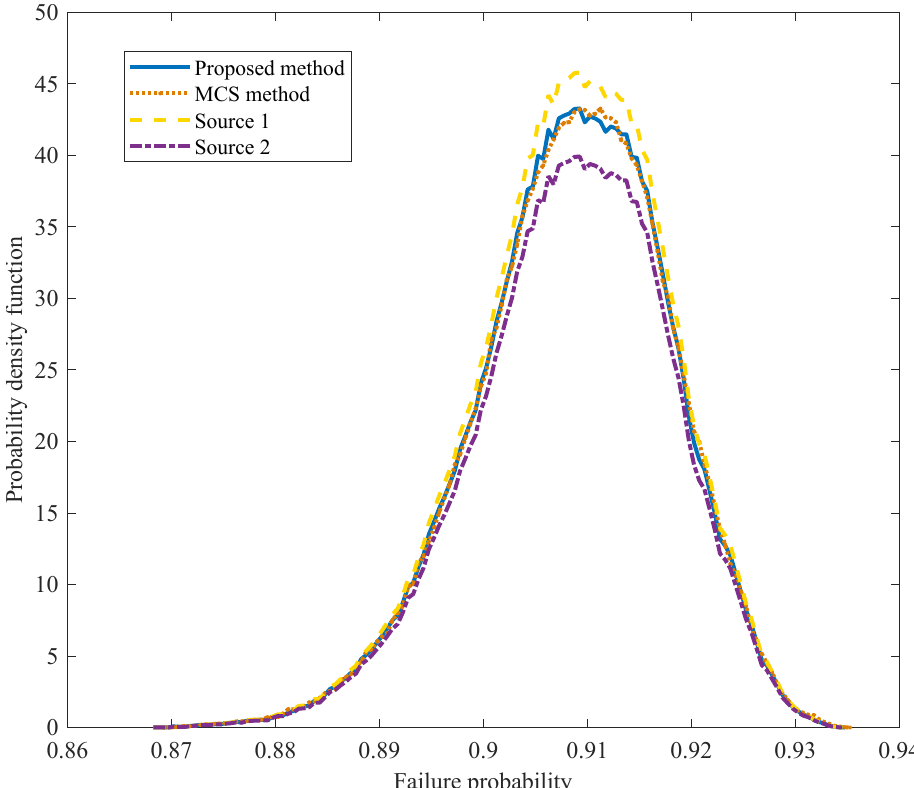
Figure 5. Failure probability of composite laminated